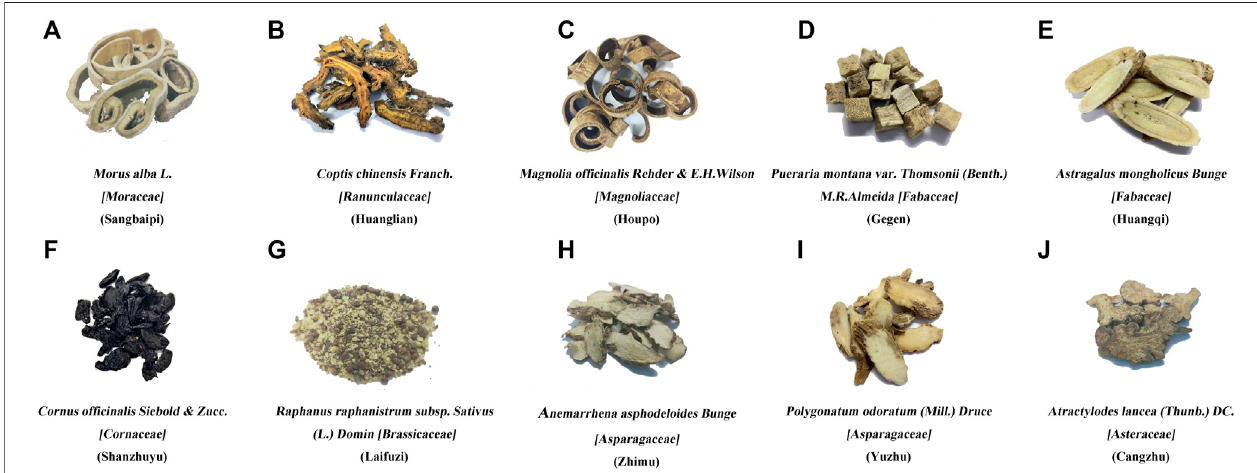
FIGURE 1 | Composition of Sanghuang Tongxie Formula. The photographs show the composition of SHTXF (Sanghuang Tongxie formula). Morus alba L . [Moraceae] Sangbaipi, (A) , Coptis chinensis Franch. [Ranunculaceae] [Huanglian, (B) ], Magnolia of fi cinalis Rehder and E. H. Wilson [Magnoliaceae] [Houpo, (C) ], and Pueraria montana var. Thomsoni ( Benth. ) M.R.Almeida [Fabaceae] [Gegen, (D)] , Astragalus mongholicus Bunge [Fabaceae] [Huangqi, (E) ], Cornus of fi cinalis Siebold & Zucc. [Cornaceae] [Shanzhuyu, (F) ], Raphanus raphanistrum subsp. Sativus ( L. ) Domin [Brassicaceae] [Laifuzi, (G) ], Anemarrhena asphodeloides Bunge [Asparagaceae]; Zhimu, (H) , Polygonatum odoratum ( Mill. ) Druce [Asparagaceae] [Yuzhu, (I) ], and Atractylodis rhizama [Cangzhu, (J)